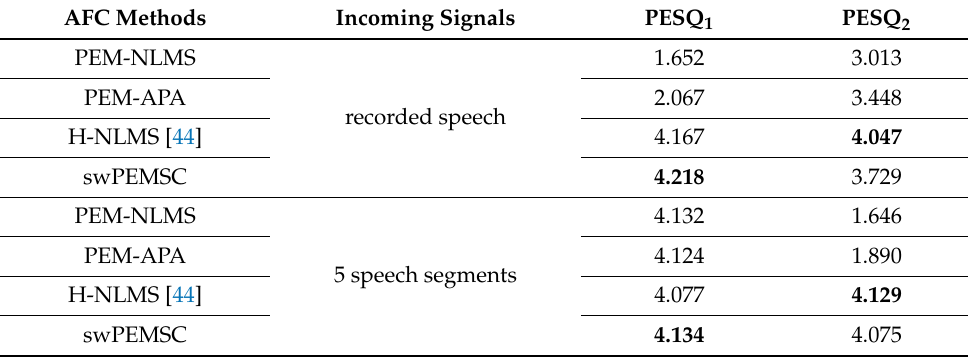
Table 3. PESQ measures of the PEMSC-NLMS, PEMSC-APA, H-NLMS, and swPEMSC with a sudden change of feedback paths from F 1 to F 2 after half of the simulation time, recorded speech and 5 segments of speech input as incoming